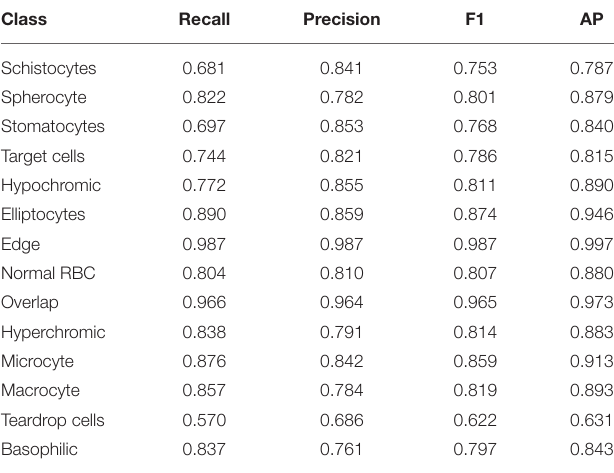
TABLE 4 | Results of different red blood cells by the CS-ARFPN model. Class F1